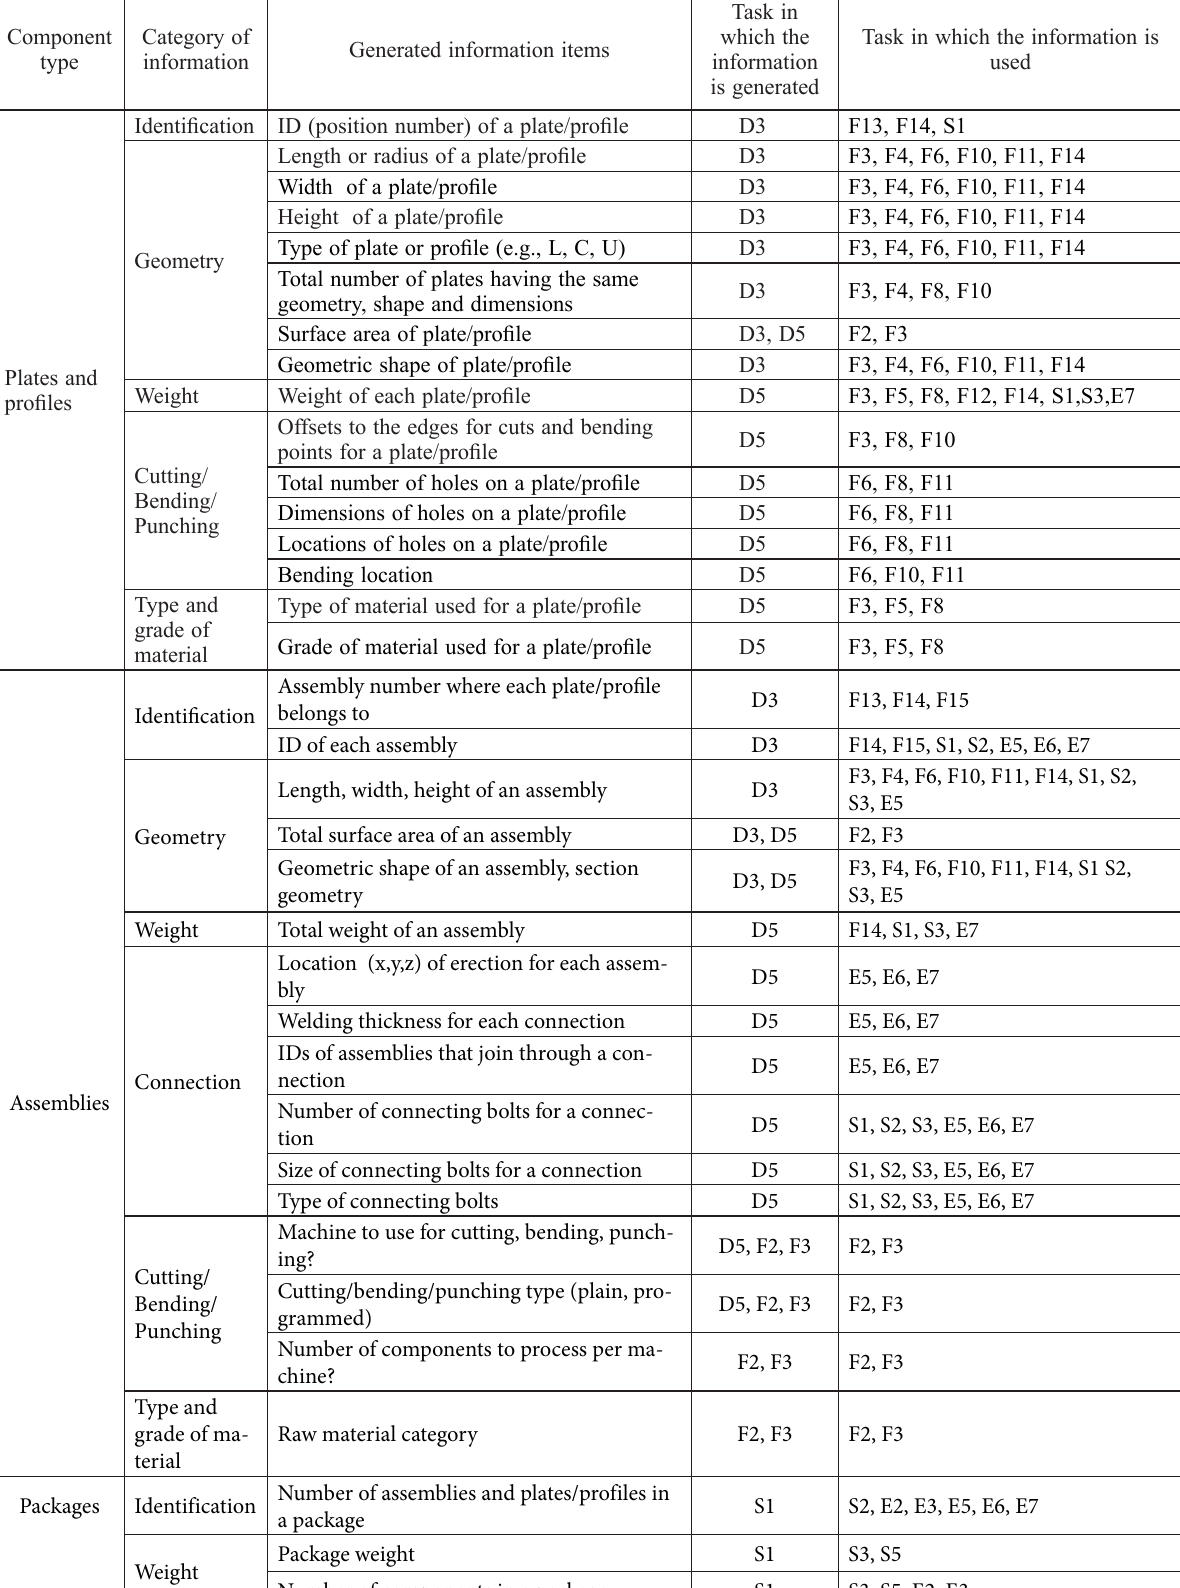
Table 3. Information items generated during design, fabrication, shipment, and erection of structural steel members Component